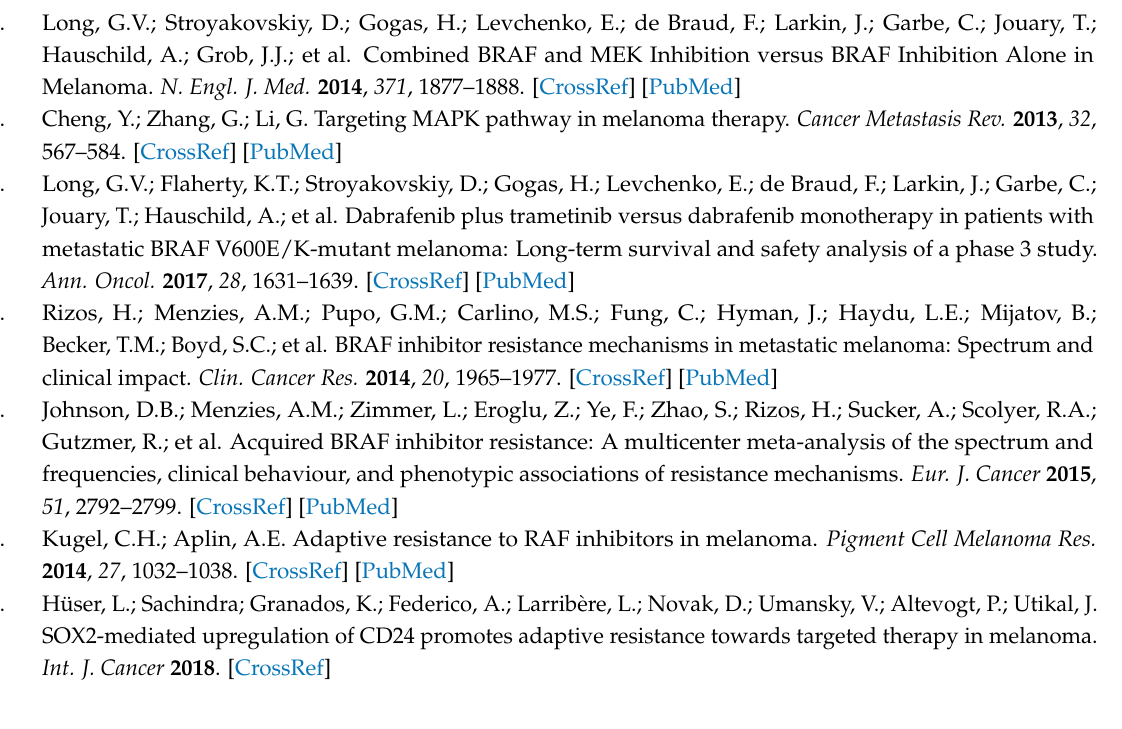
Figure S1: Gene clustering from melanoblast samples, sensitive, adaptive and acquiredvs resistant melanoma samples; Figure S2: Real-time qPCR analysis of candidate genes’ expression: ID1 , ID2 , ID3 , FOXD3 , NGFR , JUN , and RRAS , in sensitive and resistant melanoma cell lines A375, SKmel28, and WM266-4. Table S1: Regulated genes in hiPSC-MB and MBrc; Table S2: Regulated genes in melanoblast and resistant melanoma; Table S3: Adaptive resistance genes in melanoblasts; Table S4: Acquired resistance genes in